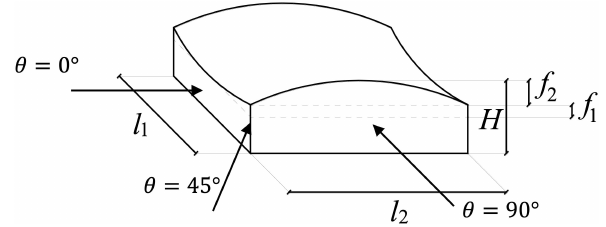
Figure 1: Geometrical characteristics of the scaled models